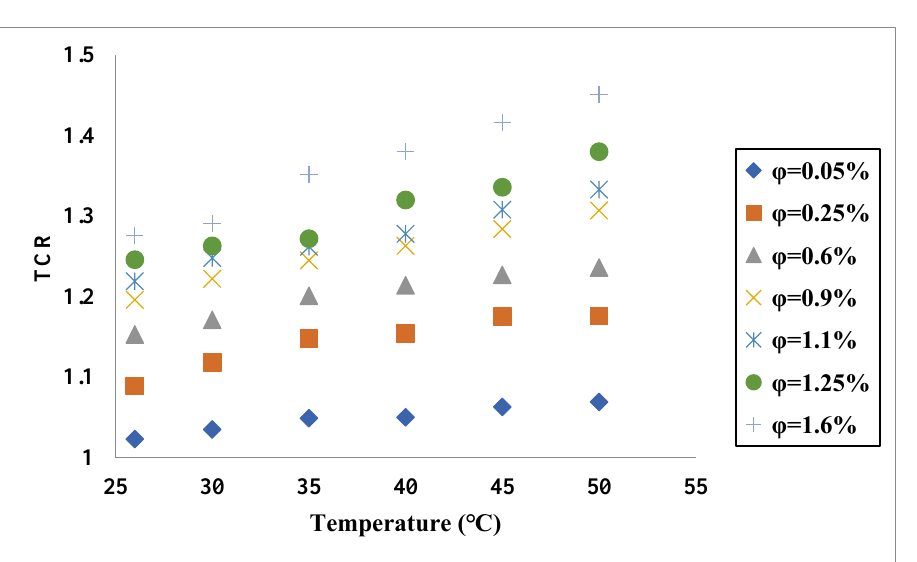
Figure 5. TCR of SiO 2 − TiO 2 /water-EG for different temperatures and VFs and T = 80 °C. Adapted from Ref. [50]. Hybrid nanofluids are not restricted to the ones containing two dissimilar materials. Cakmak et al. [53] prepared a hybrid nanofluid composed of three materials as nanostruc- tures, including reduced graphene oxide (rGO), Fe 3 O 4 and TiO 2 and EG as the base fluid. The ranges of concentrations and temperatures considered in their study were 0.01 – 0.25% mass and 25 – 60 °C, respectively. An improvement of 13.3% in the TC at temperature and concentration of 60 °C and 0.25% wt was observed compared with EG. In another work [54], the TC of a ternary hybrid nanofluid, MWCNT- TiO 2 - ZnO/water-EG, was measured in temperature and VF ranges of 25 – 50 °C and 0.1 – 0.4%, respectively. At the maximum temperature and VF, the TC enhancement was around 10%. In Table 1, the works on the hybrid nanofluids’ TC are summarized.